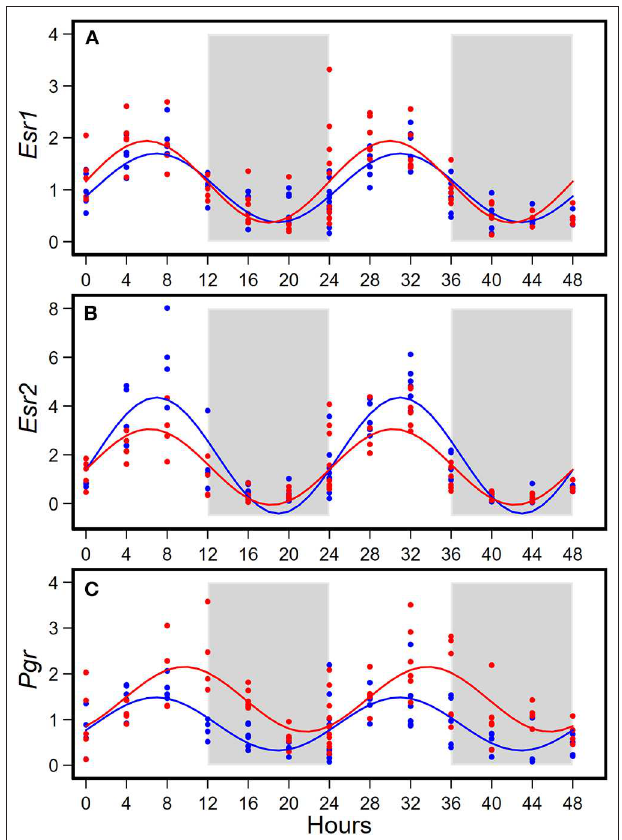
FIGURE 3 | Diurnal expressions of genes encoding estrogen receptor 1 ( Esr1 , A ), estrogen receptor 2 ( Esr2 , B ), and progesterone receptor ( Pgr , C ) in mammary glands from pubertal mice fed AIN93G or high-fat diet ( n = 5 per time point per group). Open background: light phase; gray background: dark phase; blue circles and line: AIN93G diet; red circles and line: high-fat diet. The rhythm curves were generated by using the Cosinor model y = mesor + amplitude x Cos [2 π /24 ×